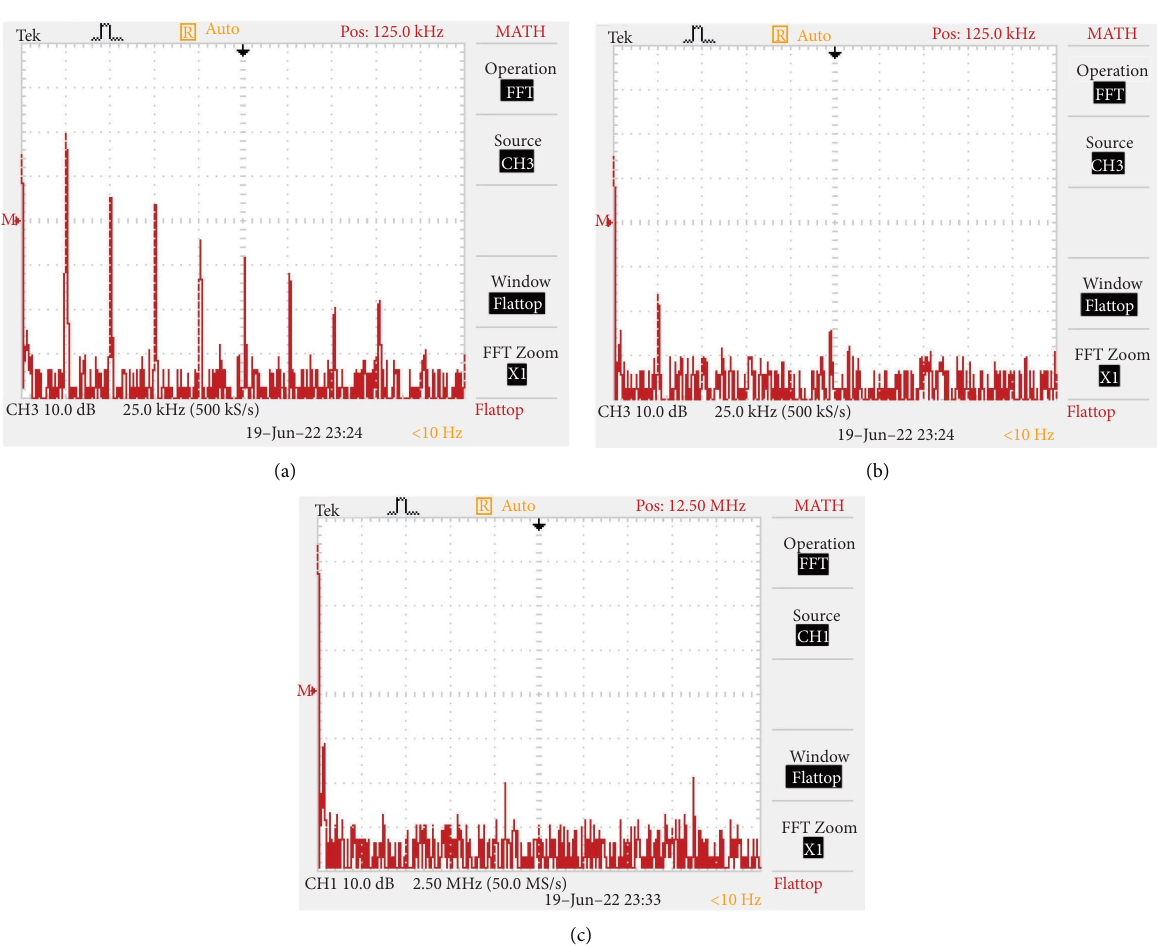
Figure 15: (a) I L 1 at 25kHz, (b) I in at 25 kHz, and (c) I in at 2.5 MHz with LC flter with series